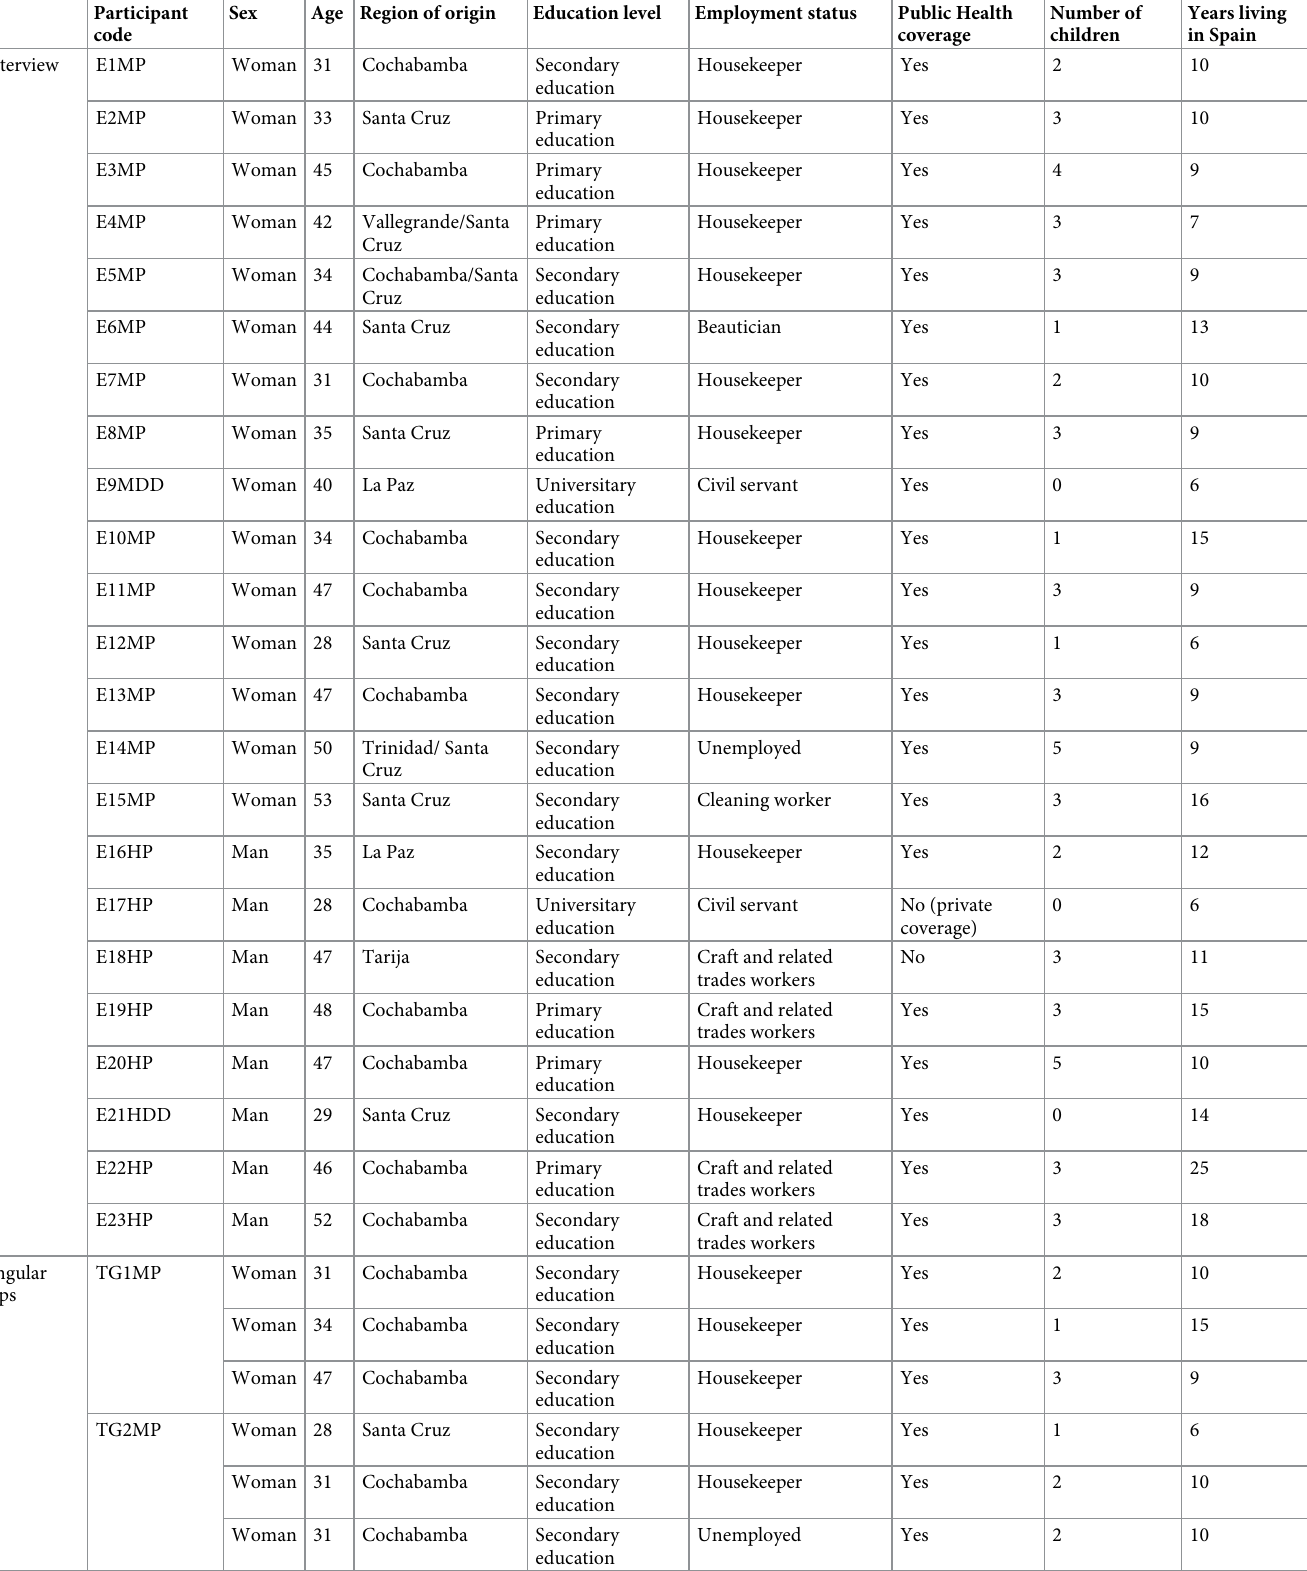
Table 2. Sociodemographic data of Bolivian population. Participant